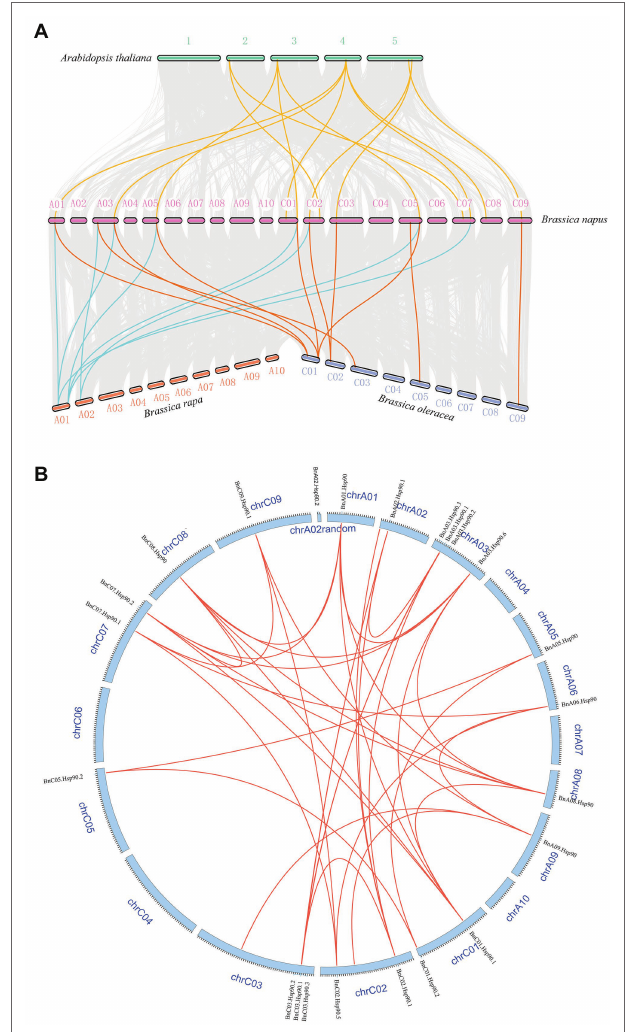
FIGURE 3 | Syntenic relationships of Hsp90s among A. thaliana , B. rapa , B. oleracea , and B. napus . (A) Hsp90 genes are plotted against their predicted counterparts in the four species. The chromosomes of A. thaliana are displayed as number 1–5, and the chromosomes of B. napus are showed in the form that symbol starting with A represents the chromosome originating from B. rapa , and symbol starting with C denotes the chromosome from B. oleracea . The chromosomes of B. rapa and B. oleracea are named using symbols beginning with A and C, respectively. The grey lines indicate the collinear blocks between different species. The yellow lines represent the collinear Hsp90 gene pairs between A. thaliana and B. napus . The blue lines denote the collinear Hsp90 gene pairs between B. napus and B. rapa , and the orange lines display the collinear gene pairs between B. napus and B. oleracea . (B) The collinear gene pairs of BnHsp90s on B. napus chromosomes. Red lines were used to link a pair of collinear genes. The ID of each chromosome was represented using “chr” followed by its ID, and the name of each gene was indicated on the corresponding